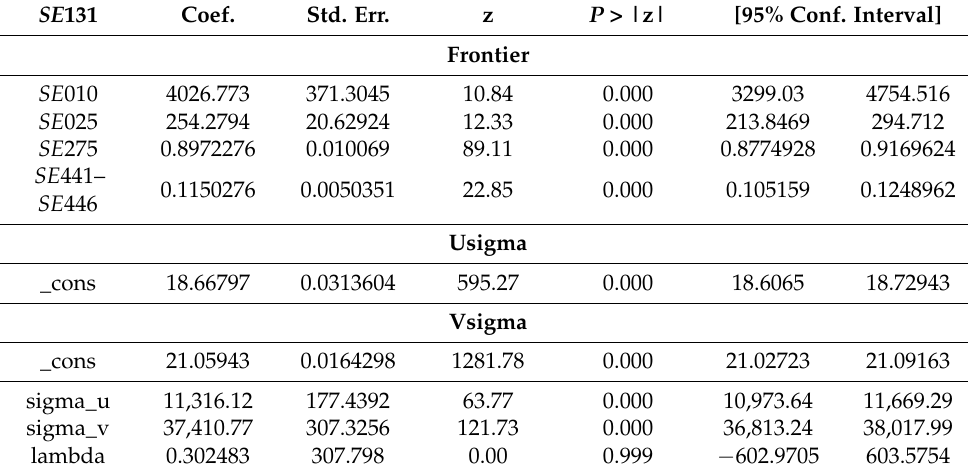
Table 3. Parameters of the estimated SFA model. SE 131 Coef. Std.